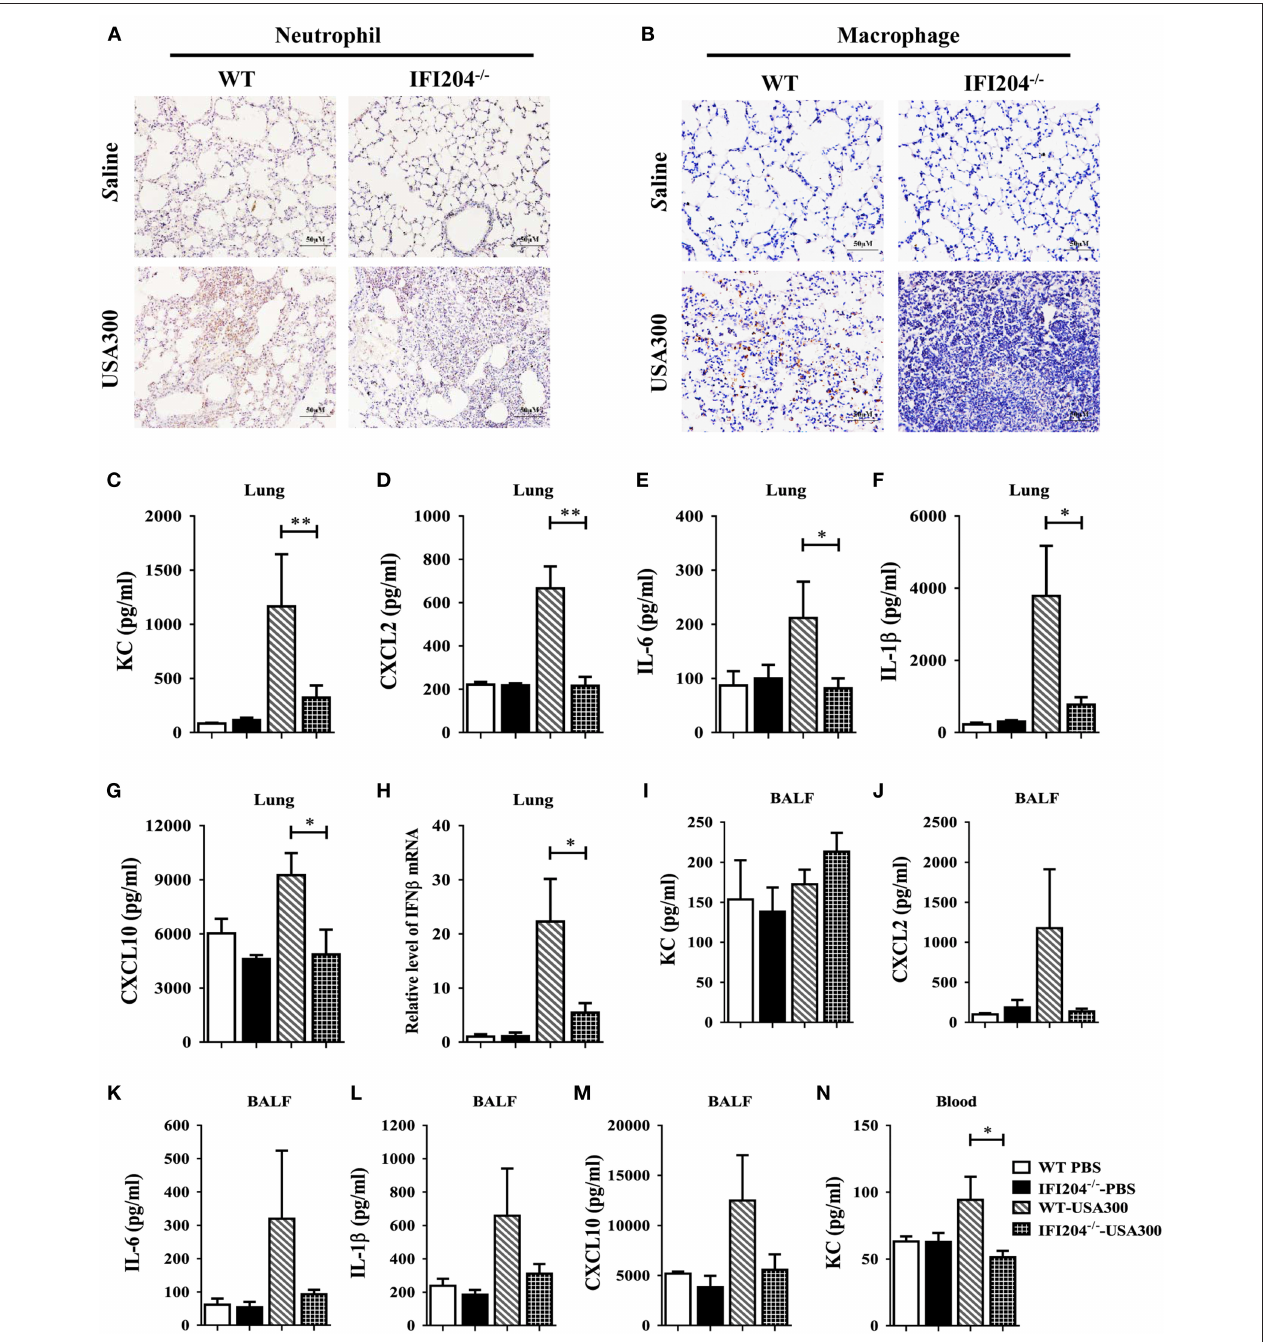
FIGURE 2 | IFI204 is required for elevated inflammatory cells recruitment and cytokines/chemokines production after Staphylococcus pulmonary infection. WT and IFI204 − / − mice ( n = 10 each group) were infected intranasally with 1 × 10 8 CFU of Staphylococcus for 24h. Representative immunohistochemical staining of (A) Gr-1 (a neutrophil marker) and (B) F4/80 (a macrophagocyte marker) were performed in the lung sections. (C–N) Levels of KC, CXCL2, IL-6, IL-1 β , CXCL10, and IFN- β in lung, BALF or blood were determined. All data are shown as mean ± SEM. Student’s t -test was performed. * p < 0.05; ** p < 0.01.